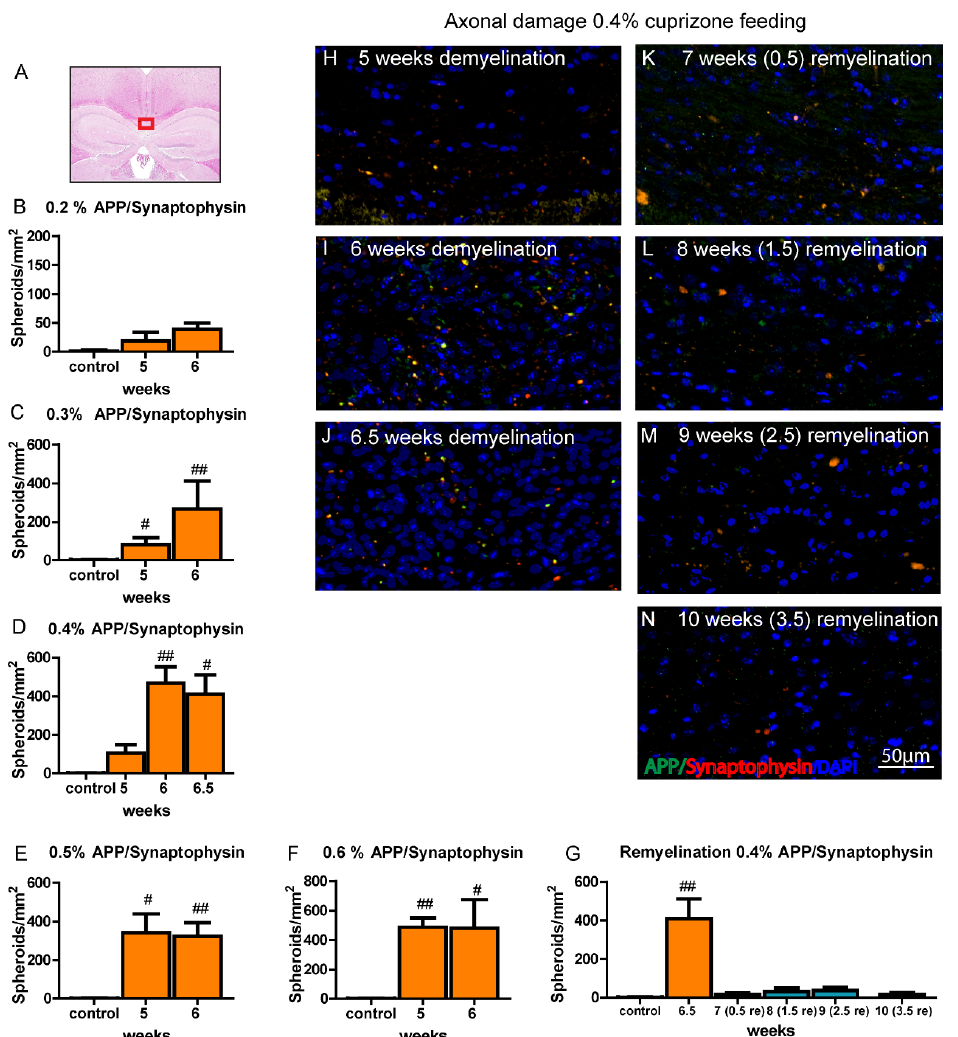
Figure 9. Axonal pathology during cuprizone-induced demyelination in aged mice. The medial part of the corpus callosum that was analyzed is highlighted ( A ). Graphs ( B – G ) represent number of APP / Synaptophysin double positive spheroids / mm 2 per time point and group in aged mice during di ff erent cuprizone treatments protocols. Bars show mean + SEM. Significant e ff ects between di ff erent analyzed time points are indicated by asterisks and e ff ects in comparison to control are indicated by hashmarks (* / # p < 0.05; ** / ## p < 0.01; *** / ### p < 0.001). 6.5 weeks = feeding period of 0.4% cuprizone in aged mice; 7 (0.5 re) weeks = 0.5 weeks of remyelination, 8 (1.5 re) weeks = 1.5 weeks of remyelination, 9 (2.5 re) weeks = 2.5 weeks of remyelination, 10 (3.5 re) weeks = 3.5 weeks of remyelination in aged mice. N = 5–6 animals per group. Representative images show axonal damage / axonal transport disturbances during de- and remyelination in aged mice as depicted by the accumulation of pathological APP / Synaptophysin-positive spheroids in the central corpus callosum ( H – N